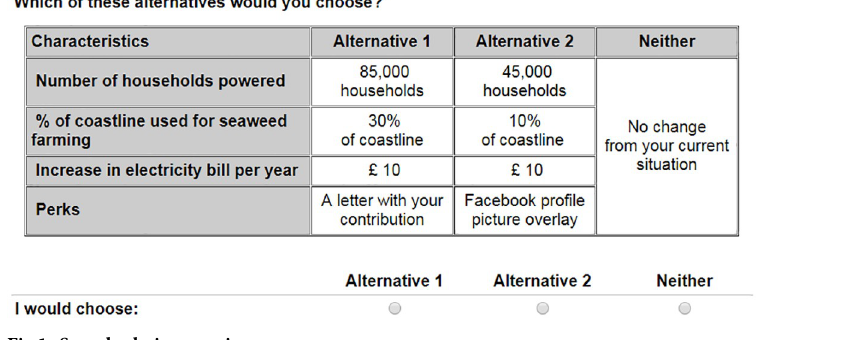
Fig 1. Sample choice occasion.